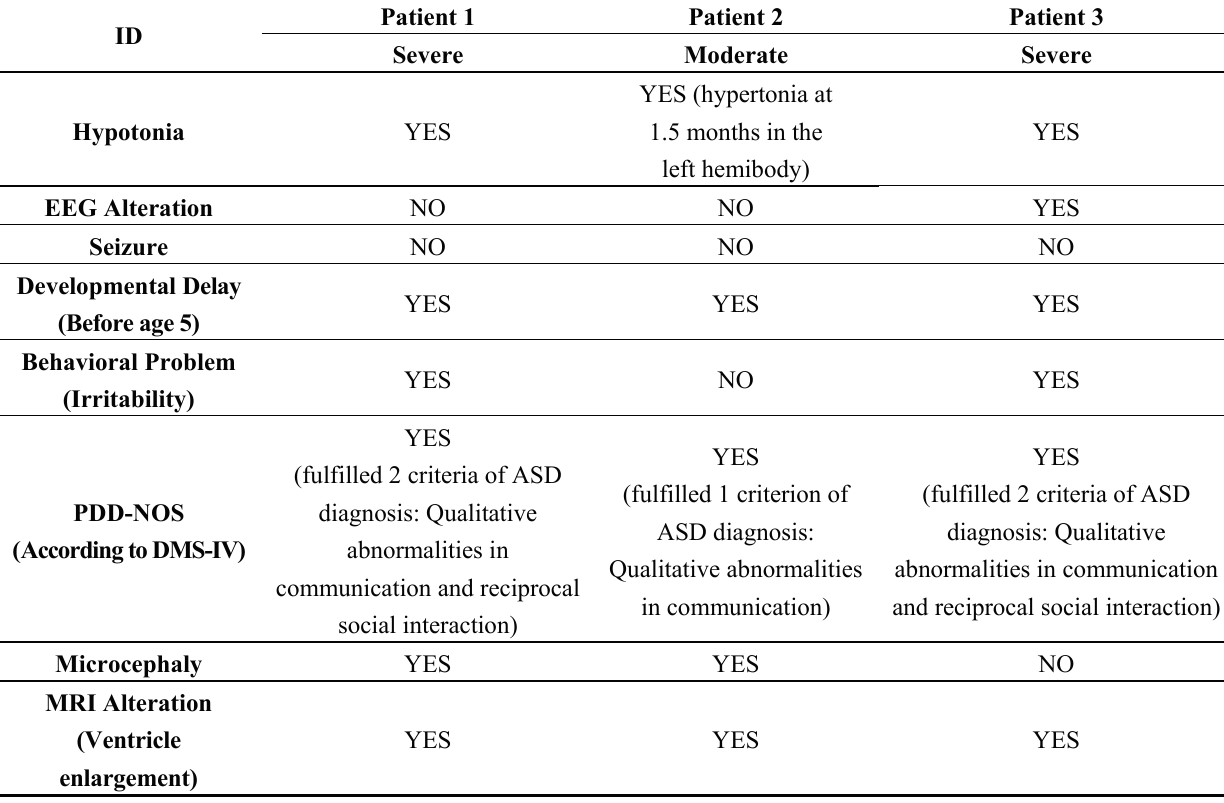
Table 1. Summary of the clinical features of the three patients described in this case